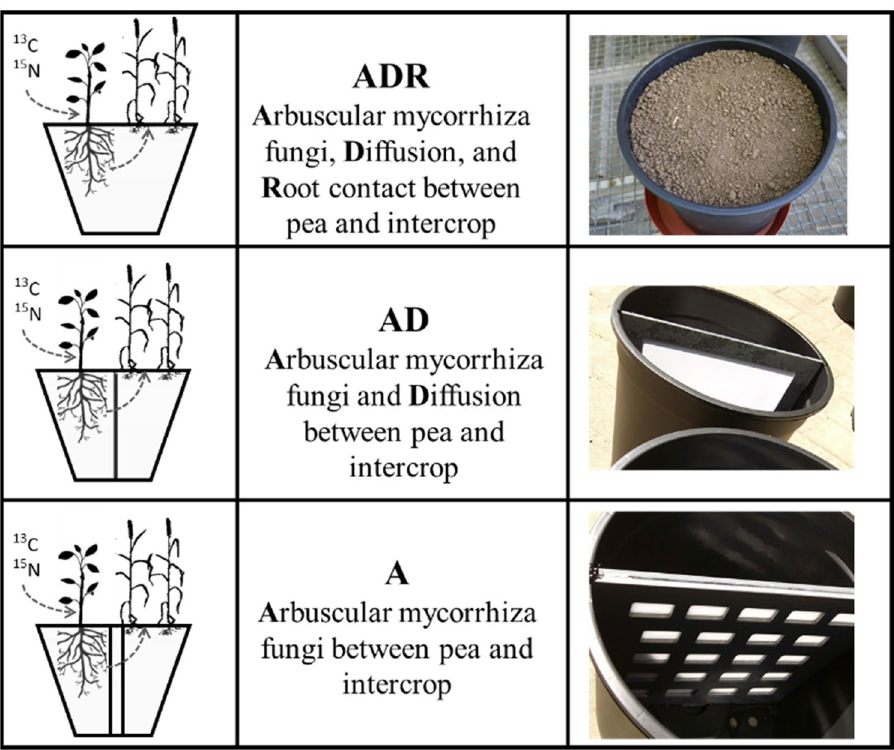
Figure 1. Schematic setting of pot trial with three treatments and the symbols used for the treatments; transfer paths: ADR = AMF, diffusion, and root contact between pea and intercrop; AD = AMF and diffusion; A = only